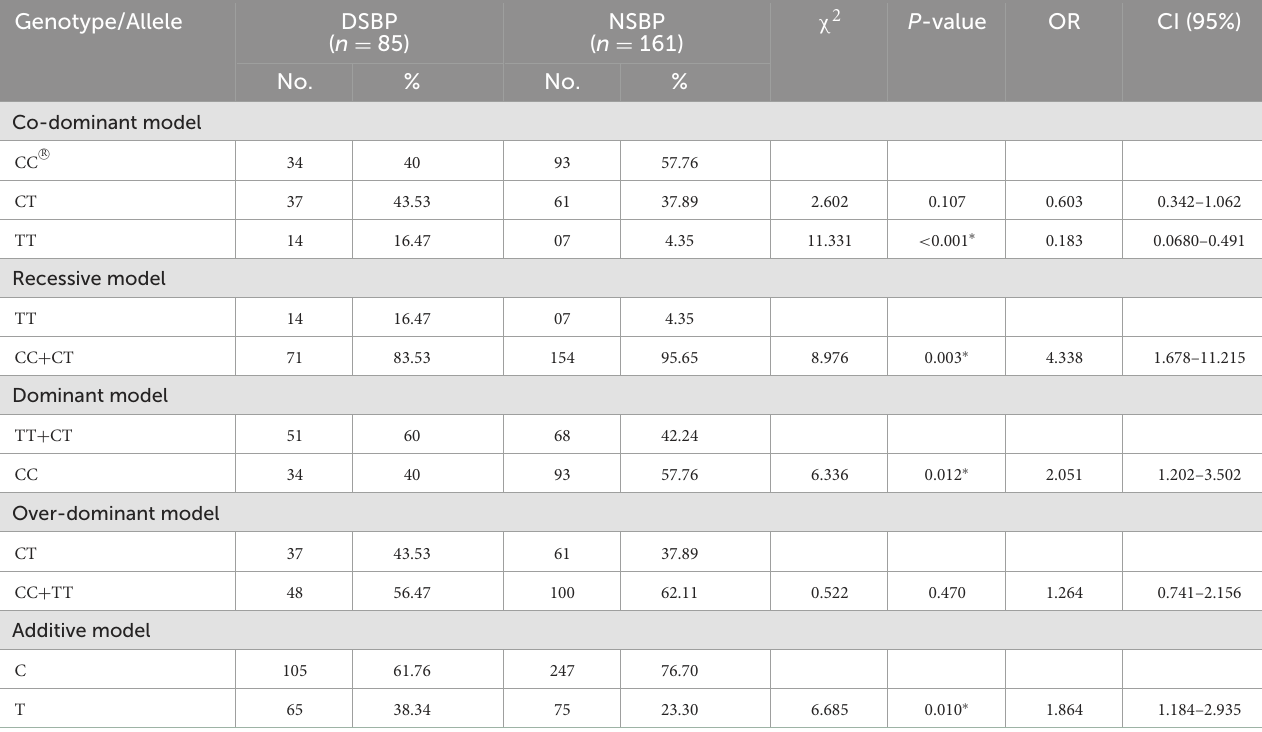
TABLE 6 BDNF gene polymorphism under co-dominant, recessive, dominant, over-dominant, and additive models in individuals with decreased SBP (DSBP) and normal SBP (NSBP). Genotype/Allele